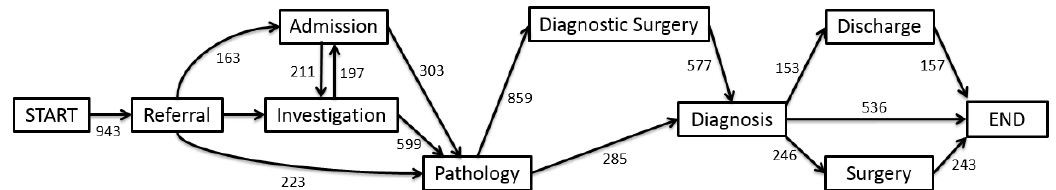
Figure 3. The Data-Aware Heuristics Miner (iDHM) process model. Originally produced by the iDHM plugin in ProM 6.8, showing the process model of the pathway from referral to diagnosis. The pathway flows from left to right, with rectangles representing activities and arrows as flows from one activity to the other. The numbers on the arrows show the number of patients with activity flows to other activities.